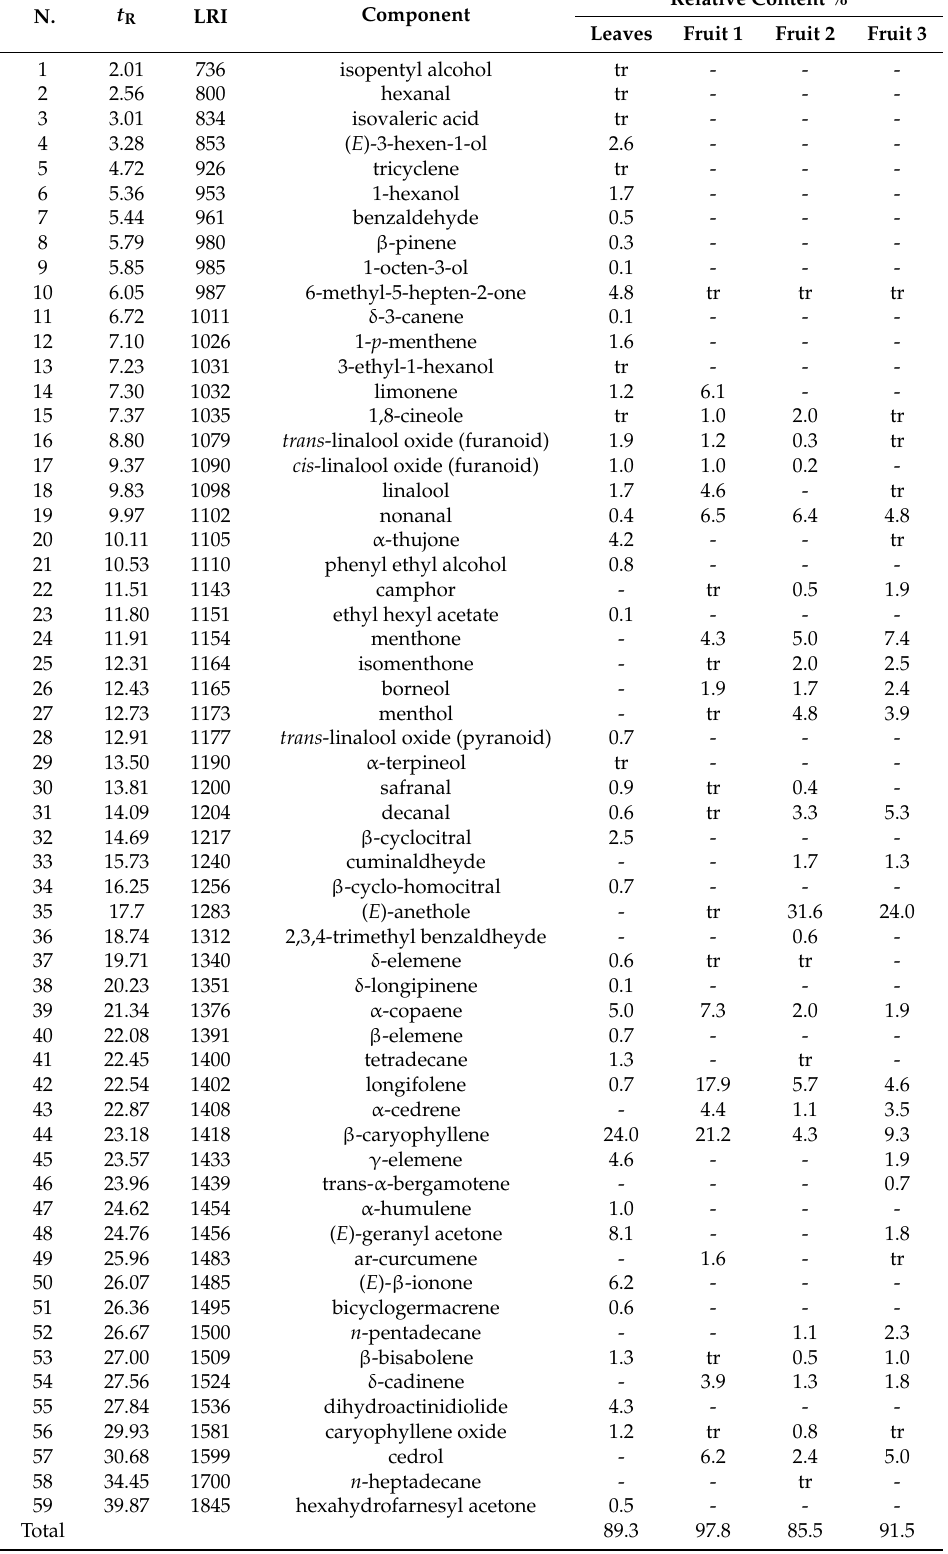
Table 4. Total volatile organic compound (VOC) profile for the baobab samples by HS-SPME-GC/MS.